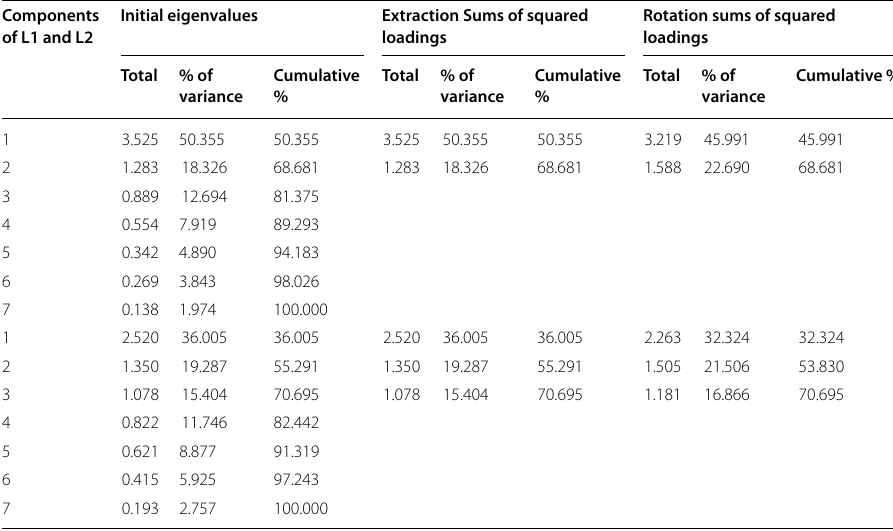
Table 12 Total variance explained for L1 and L2 Use in Oral Performance Components Initial eigenvalues Extraction Sums of squared of L1 and L2